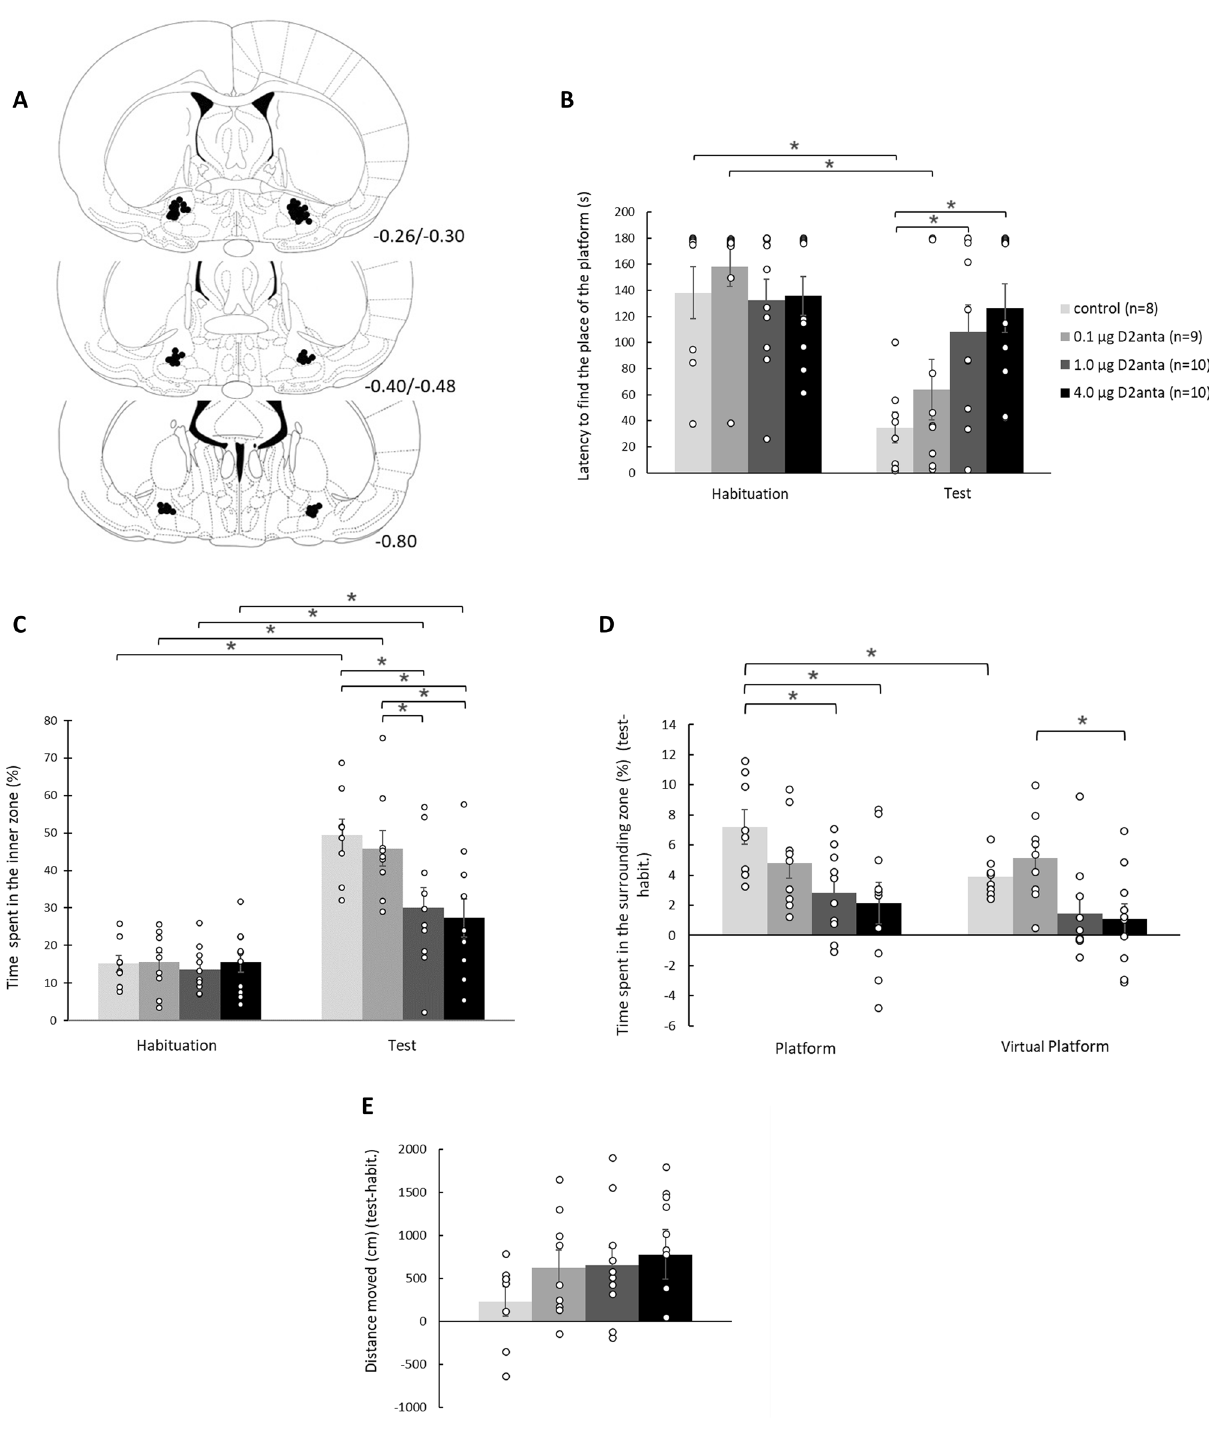
Figure 2. Effect of VP-sulpiride treatment on spatial learning in MWM test. Intra-VP sulpiride dose- dependently impairs learning processes, especially spatial learning. The intra-VP 1.0 µg and the 4.0 µg sulpiride completely impair spatial learning, but also the other, swimming-away strategy is impaired in their case. Panel ( A ) displays a schematic illustration of correct bilateral guide cannulae placement in the VP as shown in coronal sections of the rat brain taken from the Paxinos and Watson’s atlas 25 . The numbers beside refer to the anterior– posterior distance from the bregma in mm. Panel ( B ) shows the latencies (sec) to find the place of the platform, while panel ( C ) demonstrates the time spent (%) in the inner zone (r = 60) of the apparatus in the habituation and test trials. Panel ( D ) displays the time spent (%) in the zone surrounding the place of the platform and the virtual platform (test-habituation), to reveal the specific spatial learning. Panel ( E ) shows the distance moved by the animals (cm, test-habituation). Columns represent the averages ± the standard error of the mean (S.E.M.) in all panels, results of the individual subjects (represented as black circles) are added to the bar graphs. * p < 0.05 indicates significant differences. For further explanation, see the